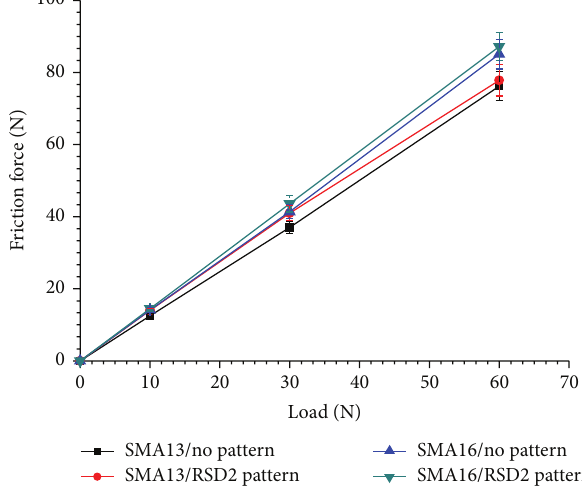
Figure 7: Friction forces versus load with SMA type roads.